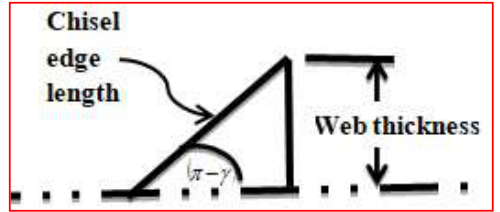
Fig.4 Geometry of the chisel edge